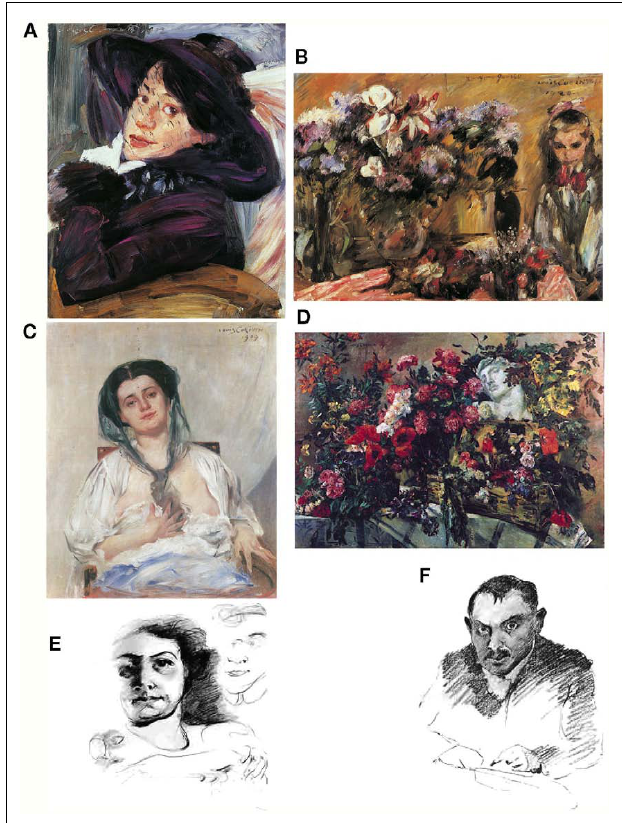
FIGURE 2 | Lovis Corinth. (A) “Portrait von Charlotte Brerend” (1912). (B) “Walchensee, Landhaus mitWäscheplatz” (1923). (C) “Die Nacktheit” (1908). (D) Hymnus an Michelangelo (1911) (E) Study of the artist’s wife (Charlotte Berend, 1912). (F) Self-portrait (1912). and arm are drawn, both show signs of spatial deformities and are lesspreciselydrawnthanthecorrespondingrightbodyparts. Ithas also been observed that her left hemiface is less wide and drawn with less spatial detail and nuances (Blanke, 2006). Corinth’s self- portrait on the right side also shows left-sided neglect suggesting thepresenceof object-centeredgraphicneglect.Thus,despiteplac- ing this self-portrait in his preserved right spatial field, Corinth omitted left facial features (eye, hair, left facial contour), suggest- ing the presence of an attentional-spatial deficit as opposed to sole perceptual-visual deficits such as hemianopia or quadranopia. The left self-portrait also shows left-sided graphic neglect (left eye and other left facial features are missing). In a later self-portrait (from 1912, Figure 2F ) further left-sided omissions can be seen (Blanke, 2006).